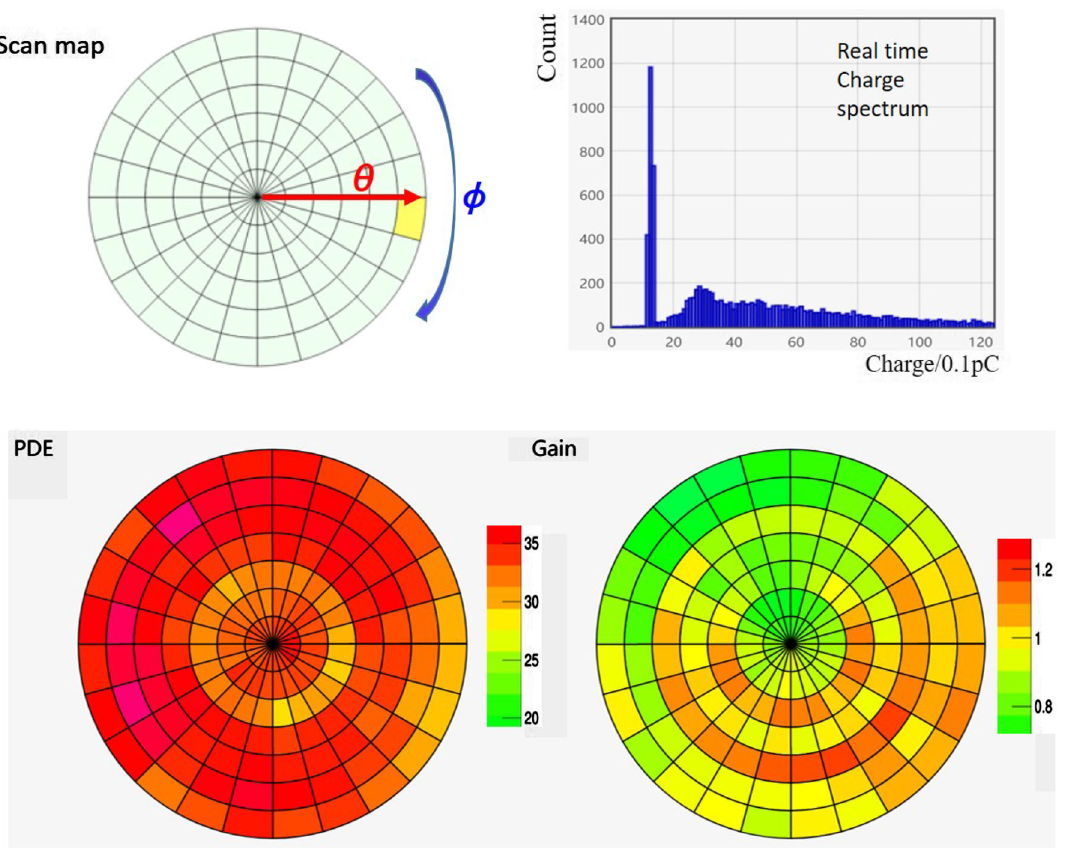
Fig. 33 Exemplary data of a PMT scan with the scanning station. Top left: scanning process indication; top right: integrated charge spectrum of selected area element; bottom: measured maps of an NNVT MCP-PMT (PA2004-1007) on PDE (bottom left) and gain (bottom right)